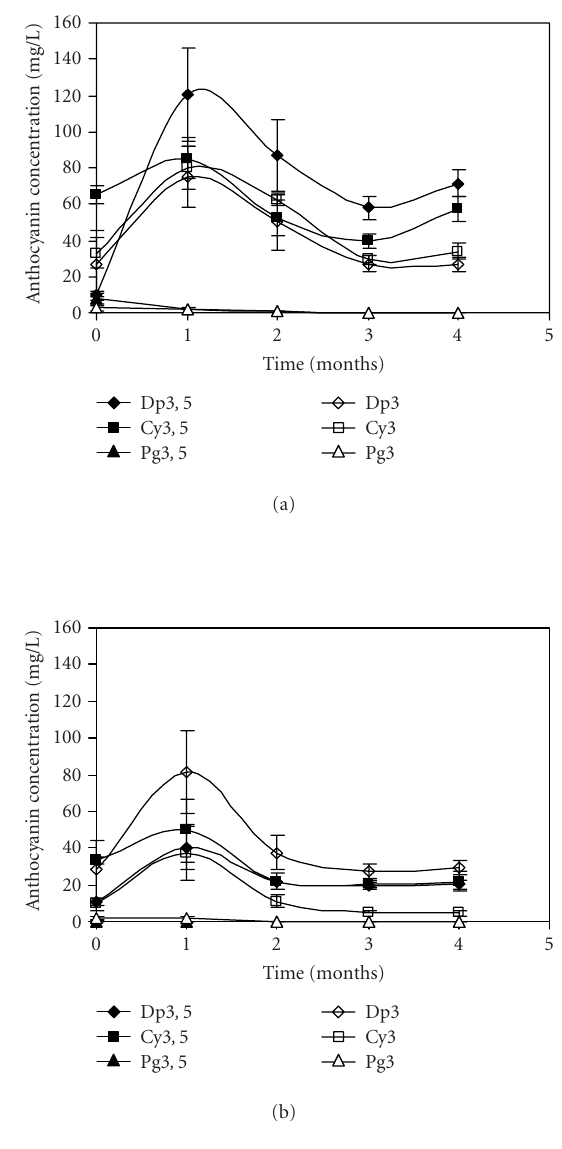
Figure 3. Evolution of delphinidin 3,5-diglucoside (Dp3,5), cyanidin 3,5-diglucoside (Cy3,5), pelargonidin 3,5-diglucoside (Pg3,5), delphinidin 3-glucoside (Dp3), cyanidin 3-glucoside (Cy3), and pelargonidin 3-glucoside (Pg3) concentration in “As- saria” pomegranate juice from control fruits, during storage at 5 ◦ C. (a) Individual anthocyanins were quantified by compar- ison with an external standard of cyanidin 3-rutinoside (Apin Chemicals). (b) The concentrations of anthocyanins were calcu- lated from standard curves of Dp3,5; Dp3; Cy3,5; Cy3, Pg3,5, and Pg3. Bars represent standard deviations of four